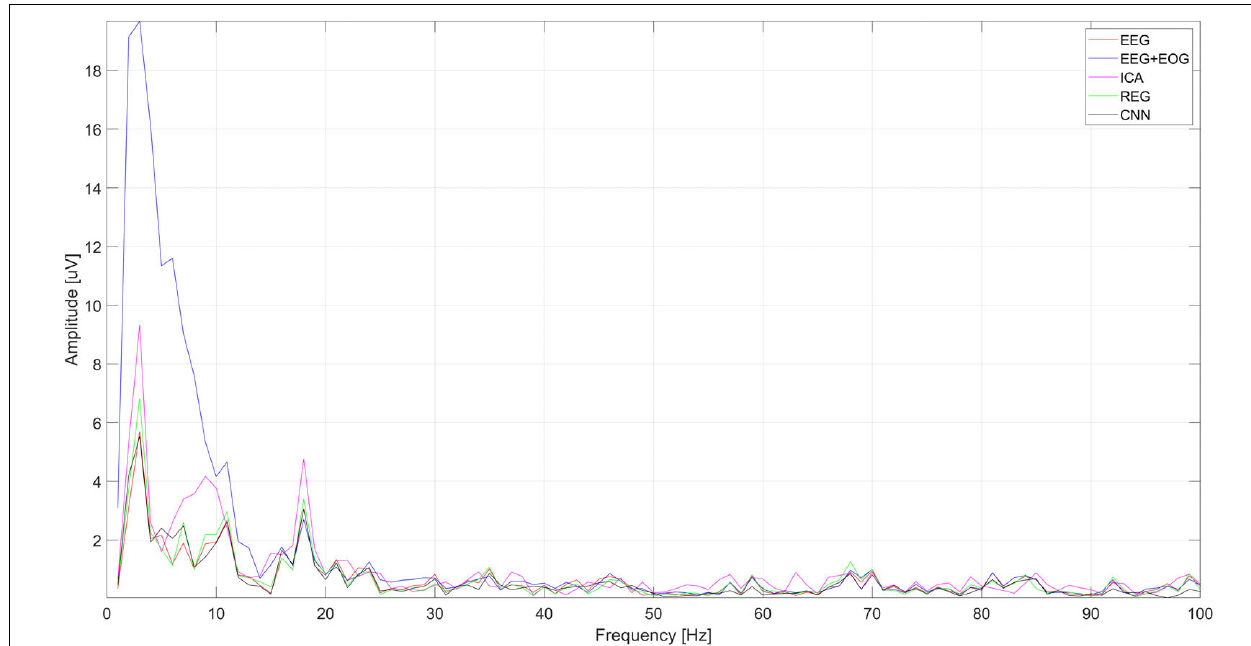
FIGURE 16 | The spectrum of the signal from the Cz electrode.